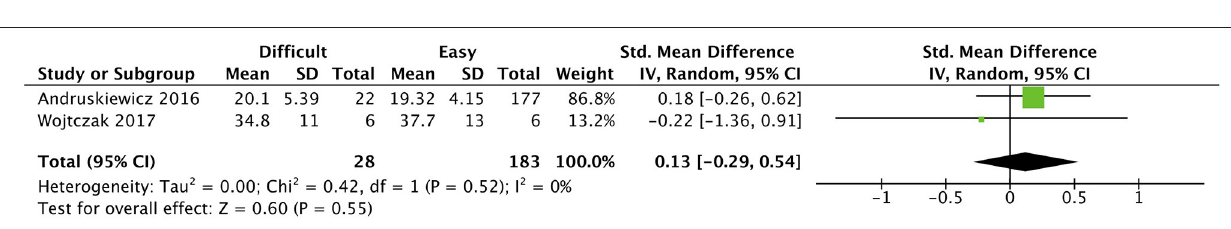
FIGURE 11 | Tongue volume forest plot comparing difficult and easy laryngoscopy groups.